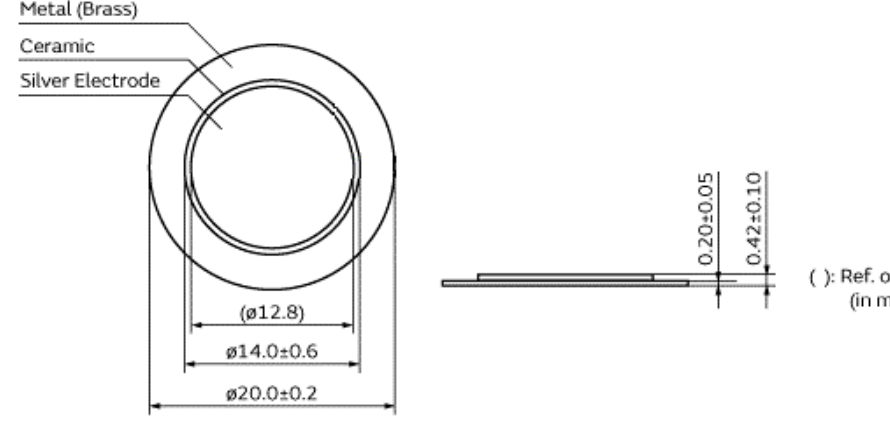
Figure 1. Buzzer representation according to Murata © [13].